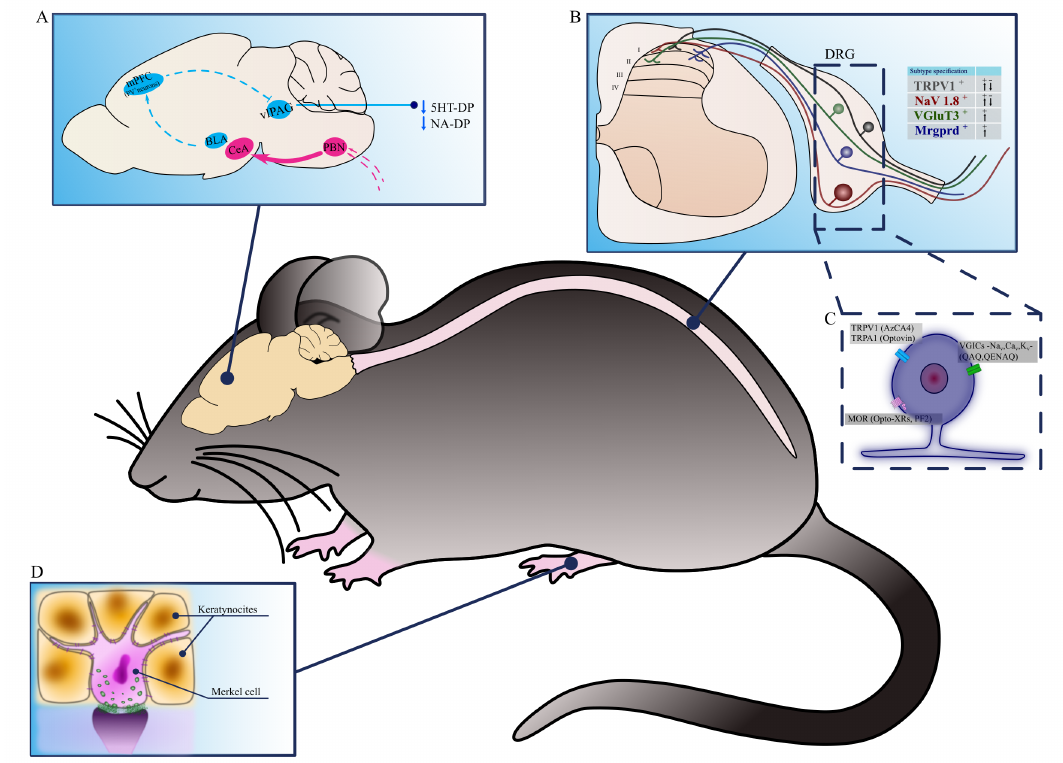
Figure 2. Biological targets of optogenetics and photopharmacology in pain research. Cartoon illustrating some of the targets of interest in the Central and Peripheral Nervous Systems, discussed in this review. (A) Overview of some neural circuits of pain within the brain. In light blue it is shown the pathway involving the basolateral amygdala ( BLA ), the medial prefrontal cortex ( mPFC ) and the ventro-lateral PeriAqueductal Gray area ( vlPAG ). The use of optogenetic tools has demonstrated that the modification of the inhibitory tone circuit deeply affects pain modulation during persistent chronic pain states, induced by peripheral nerve injuries. In pink it is shown the circuit between the ParaBrachial Nucleus ( PBN ) and the Central nucleus of the Amygdala ( CeA ) that has a prominent role in the affective dimension of pain. Optogenetics has begun to unravel the profound complexity of this circuit and of the specific sub-populations of neurons involved. (B) Diverse sub-populations of sensory neurons in the DRGs form connections at different levels of the substantia gelatinosa (laminae I and II) of the dorsal horn. A list of sub-populations of nociceptive neurons that have a crucial role in pain perception and have been investigated by using optogenetic tools are also shown in the picture ( Mrgprd + , TRPV1 + , NaV1.8 + , VGLUT3 + ). (C) Enlargement of a representative neuron in the DRG, showing the main molecular targets involved in nociception that can be currently targeted by specific photo-controllable drugs ( TRP channels in light blue, VGICs in green and MOR in light pink ). (D) Optogenetic tools have also been used to elicit responses in peripheral mechano-sensitive cells ( Merkel cells and keratinocytes ) in the epidermis to investigate the role of non-neuronal cells in the perception of innocuous and painful mechanical